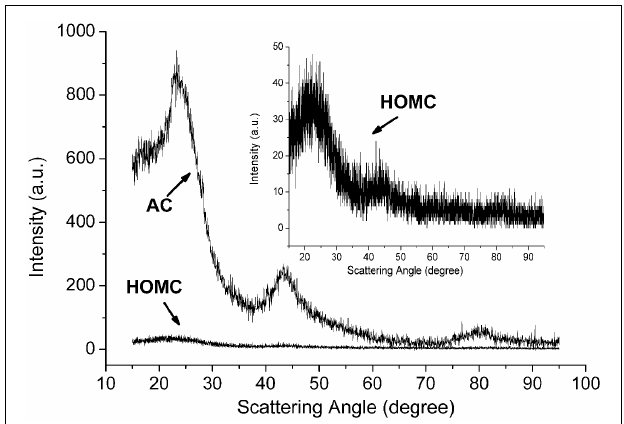
FIGURE 2 | XRD patterns of HOMC andAC .